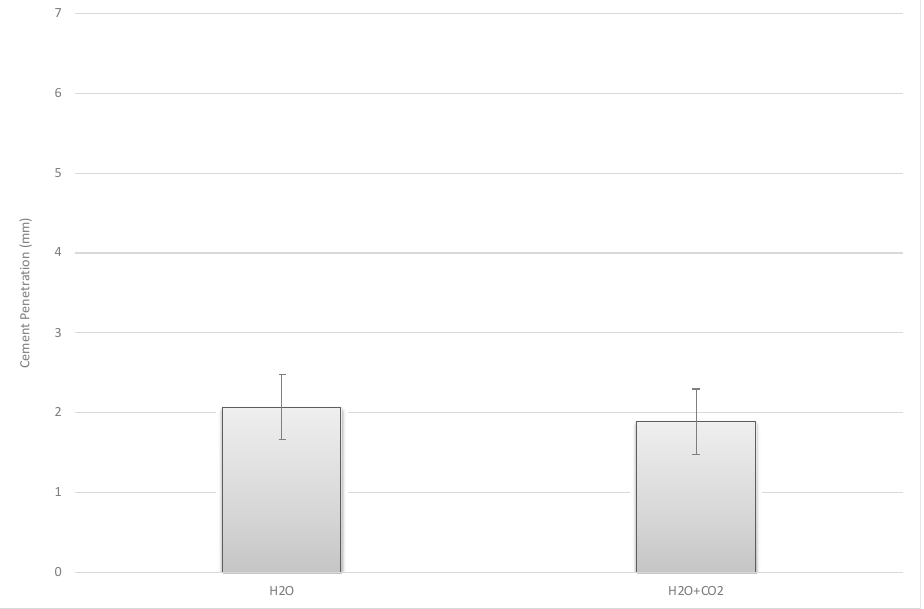
Figure 10. Mean cement penetration measurement point in the plane of cementation.